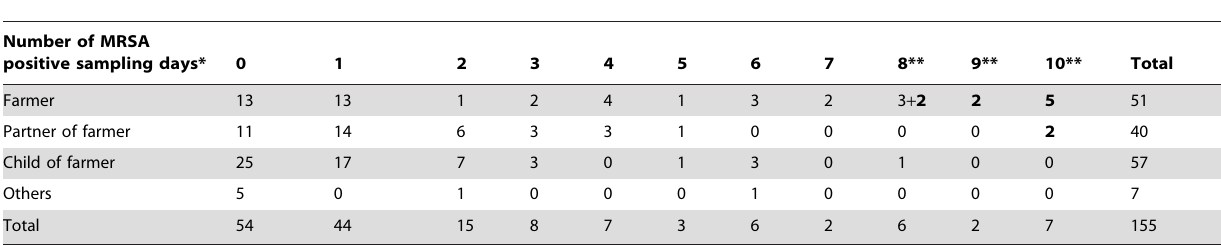
Table 4. Persistence of MRSA carriage in farmers, family members and